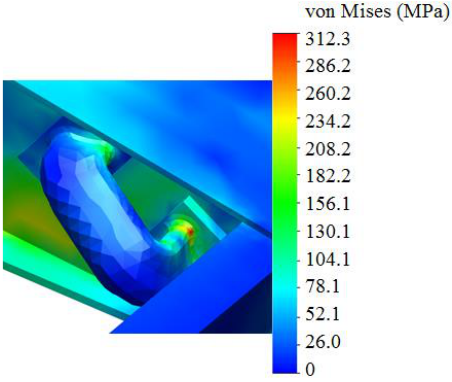
Figure 24. The stress state of the unit for fastening.